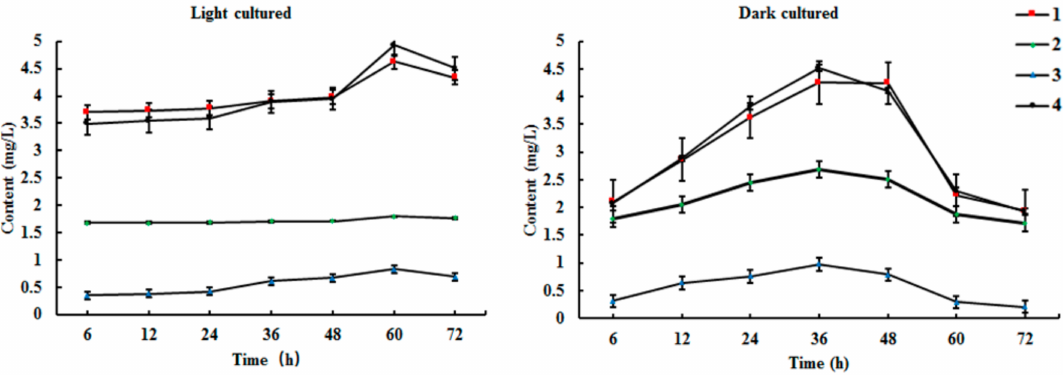
Figure 4. Time course of biotransformation of arteannuin I/J in cultured cells of A. annua ( n =